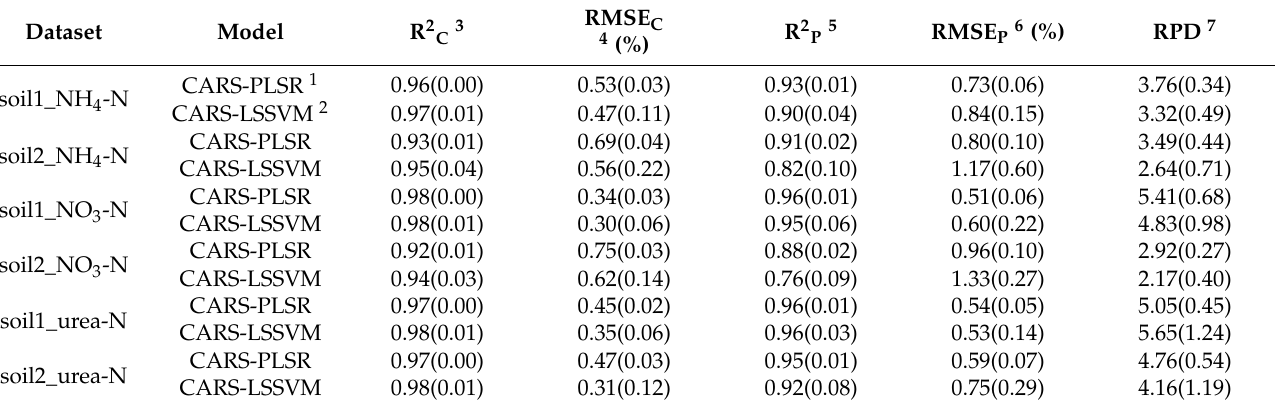
Table 4. PLSR and LSSVM model performances based on characteristic wavelengths selected by